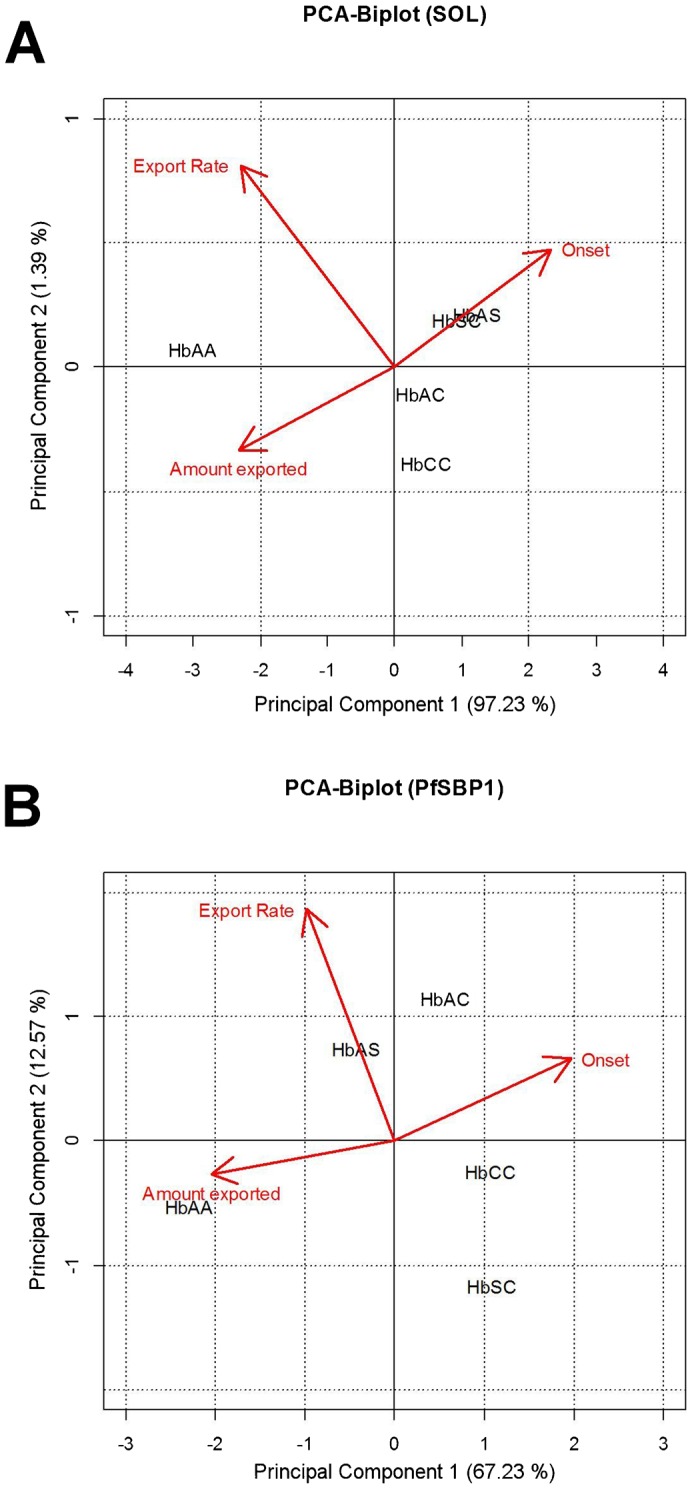
Principal component analysis (PCA) of SOLCAD and PfSBP1CAD export kinetics in erythrocytes containing different hemoglobin variants.The PCA for SOLCAD (A) and PfSBP1CAD (B) in various hemoglobinopathic erythrocytes were calculated using the export onset, rate of export, and amount of protein exported (relative to total cellular fluorescence). The biplot of the first two principal components is shown and the percentage of the total variance explained by each principal component is included in parenthesis. The variance is taken as a measure for information content for the particular axis. The plot is overlaid with the eigenvectors (red arrows) whose length and direction indicate how influential a variable is (Abdi and Williams, 2010). In both biplots, the principal component 1 was primarily driven by the amount of protein exported and secondarily by the onset of protein export. The principal component 2 was predominantly associated with the protein export rate. Clustering of different hemoglobin variants indicate similarities in the protein export behaviors of these erythrocytes.